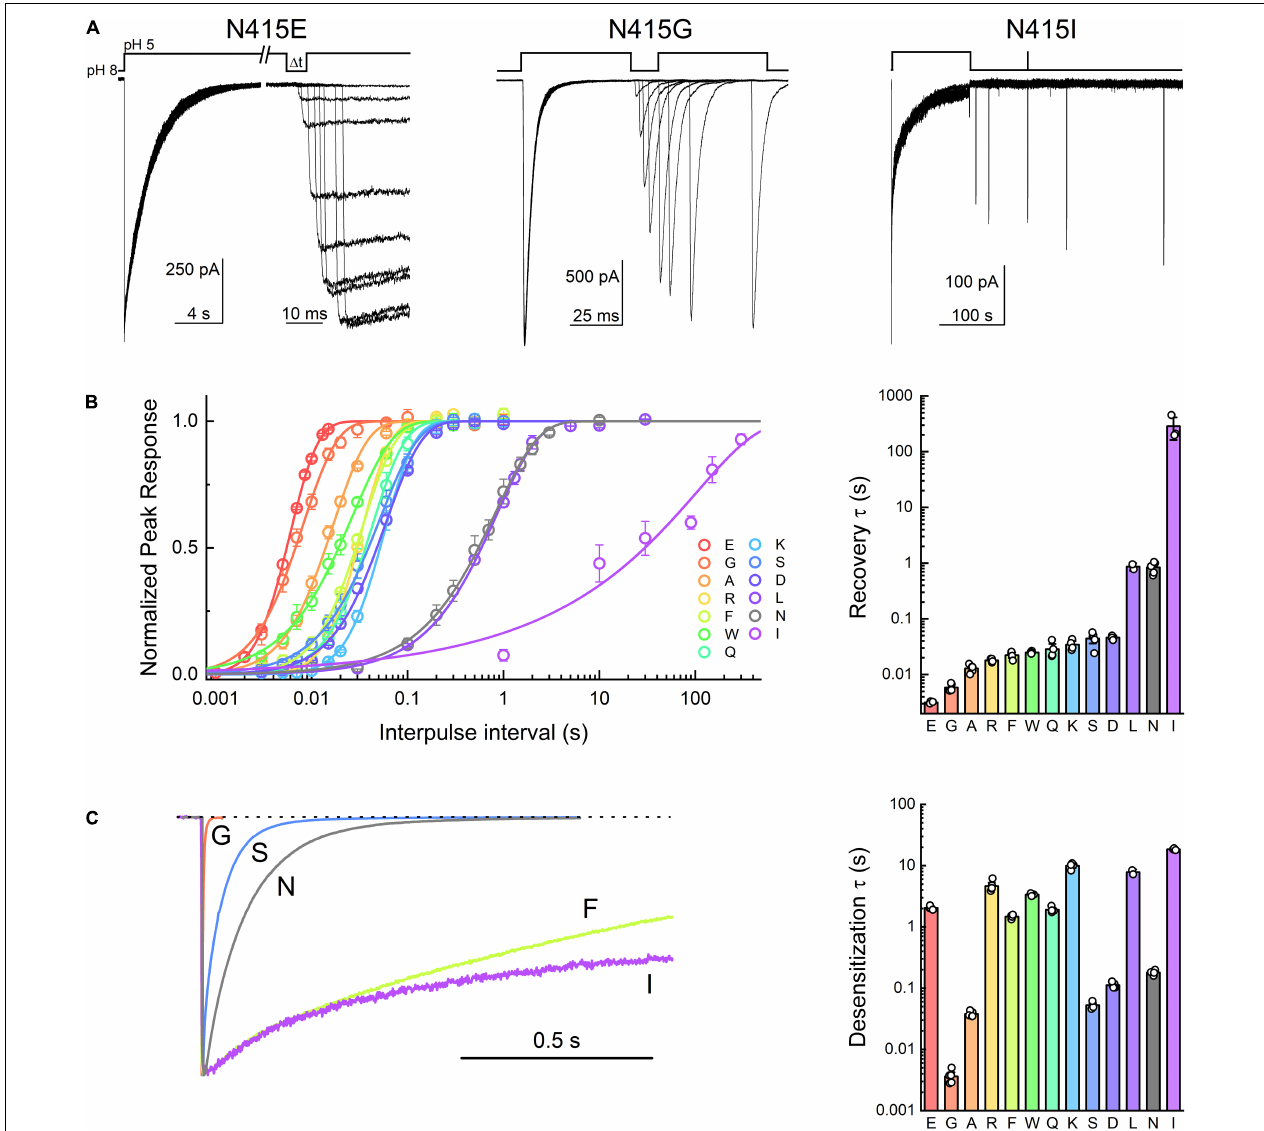
FIGURE 2 | Acid-sensing ion channel (ASIC) desensitization and recovery is altered by mutations to Asn415. (A) Example outside-out patch recordings of N415E, G, and I (left, middle, and right, respectively). Note the change in time scale in the N415E example. (B) Summary recovery time course (left) and time constants (right) for Asn415 mutant panel. (C) Example traces (left) and summary of time constants (right) for desensitization decays of Asn415 mutant panel. Symbols represent individual patches and error bars are SEM. Differences in both desensitization and recovery kinetics for all mutations were statistically significant from wild type, with the exception of N415L recovery that was not